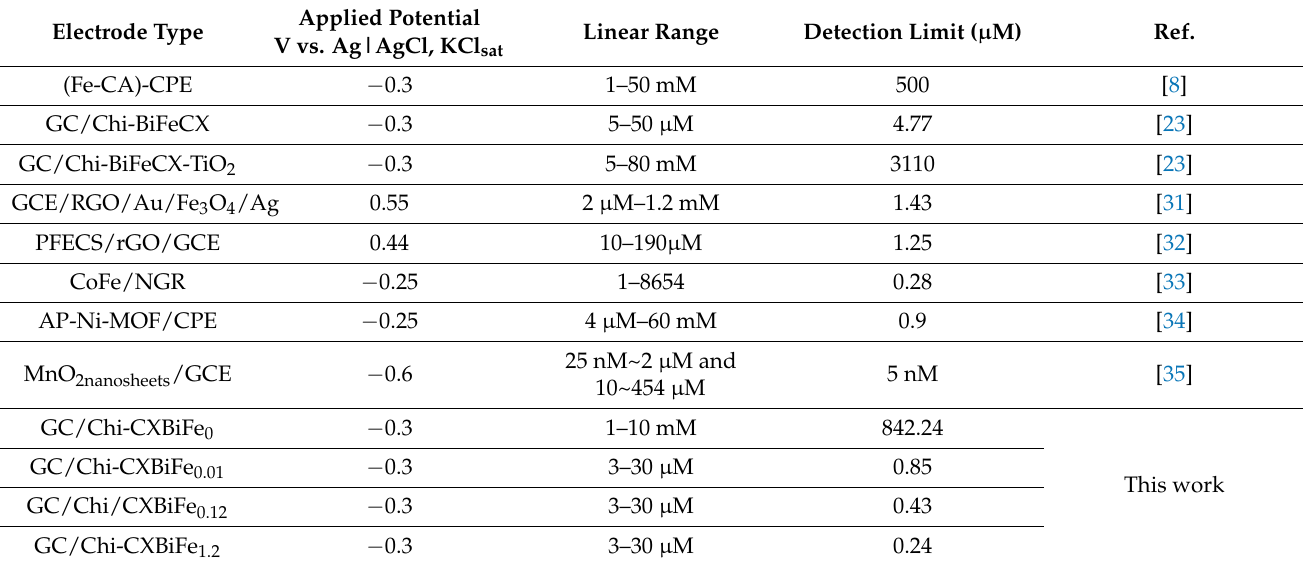
Table 5. Analytical parameters of the sensors based on carbonaceous materials used for amperometric detection of H 2 O 2